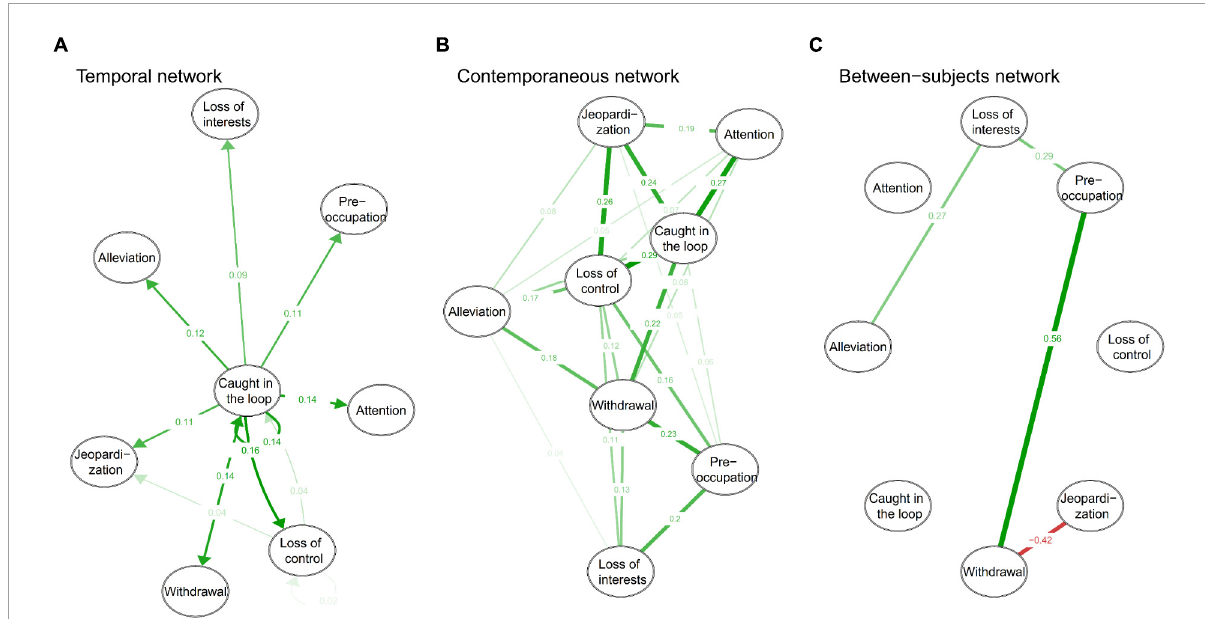
FIGURE3 Within- and between-subjects networks of PSU symptoms. (A) is temporal network, (B) is contemporaneous network, and (C) is between-subjects network. The green path represents positive prediction or correlation and the red path means negative prediction or correlation. The node paths directed to themselves (in the temporal network) are autoregressive paths, and the rest are the cross-lagged paths at the within-subjects level.